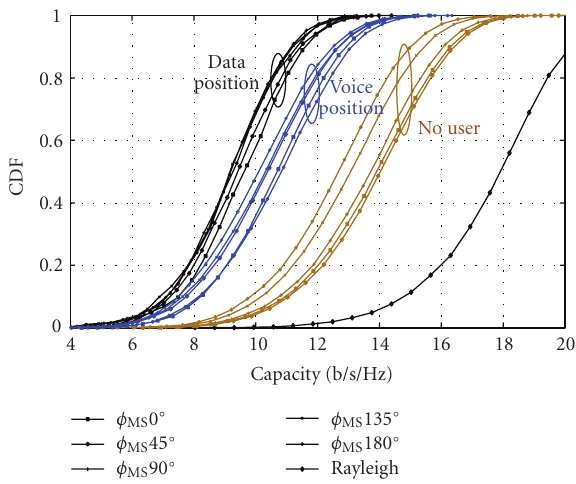
Figure 12: Capacity CDF at SNR 30 dB in the di ff erent usage scenarios at di ff erent orientations of the user.